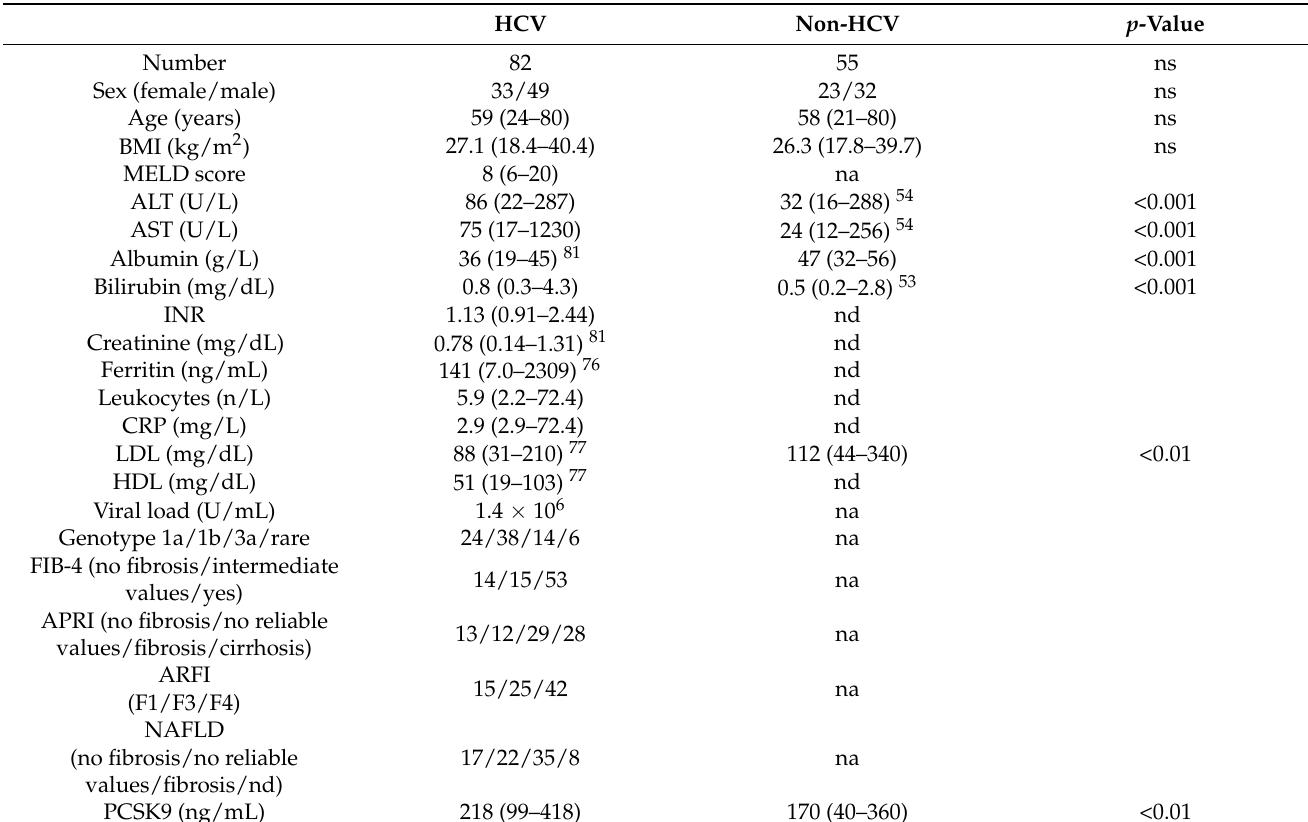
Table 1. Laboratory parameters of the HCV-infected patients and the non-infected control cohort, which included patients without severe liver diseases.